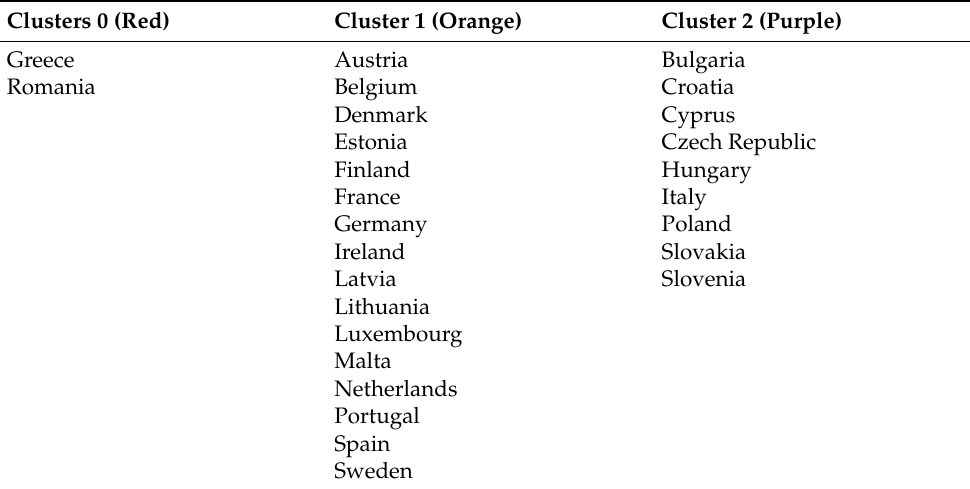
Table 5. Distribution of countries into clusters regarding digitalization indicators, K-means clustering algorithm